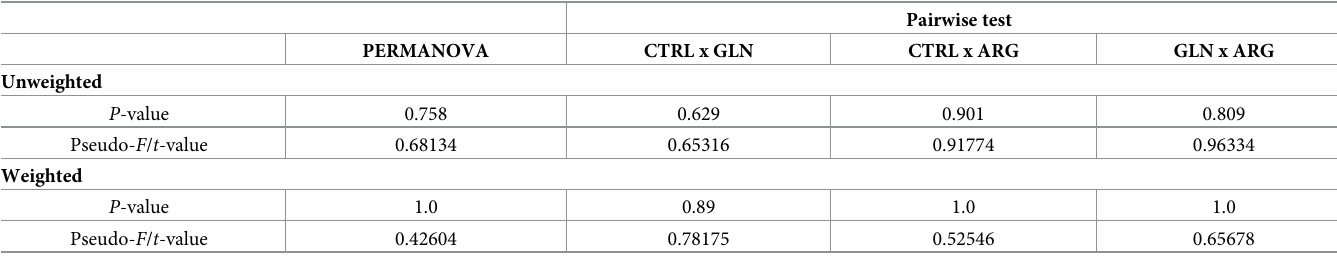
Table 3. PERMANOVA results of unweight and weighted UniFrac.